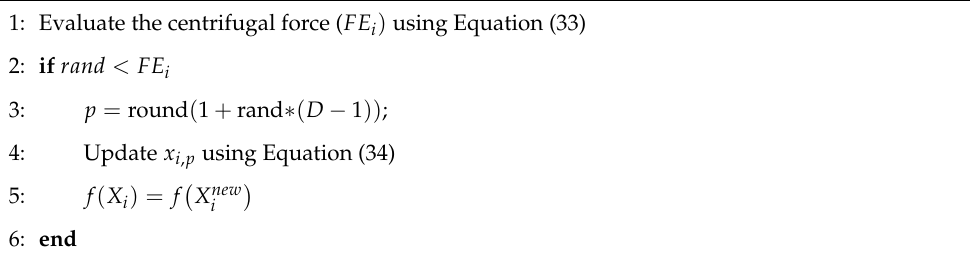
Algorithm 3. Updating p th position using the centrifugal force (Pseudo-code 3)